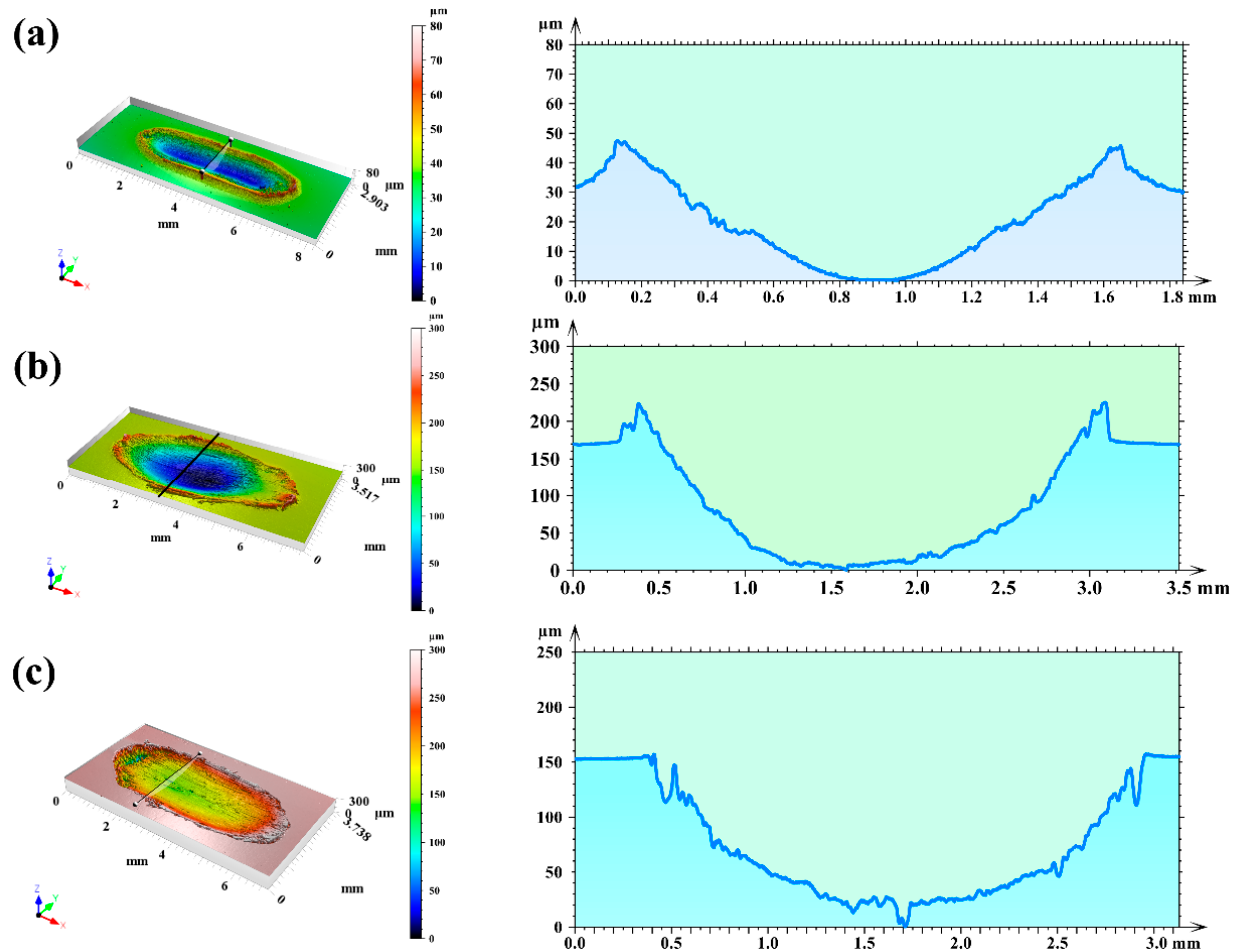
Figure 13. The three-dimensional morphology and cross-sectional depth of ( a ) AISI 316L, ( b ) Ti2, and ( c ) Zr1 after wear .